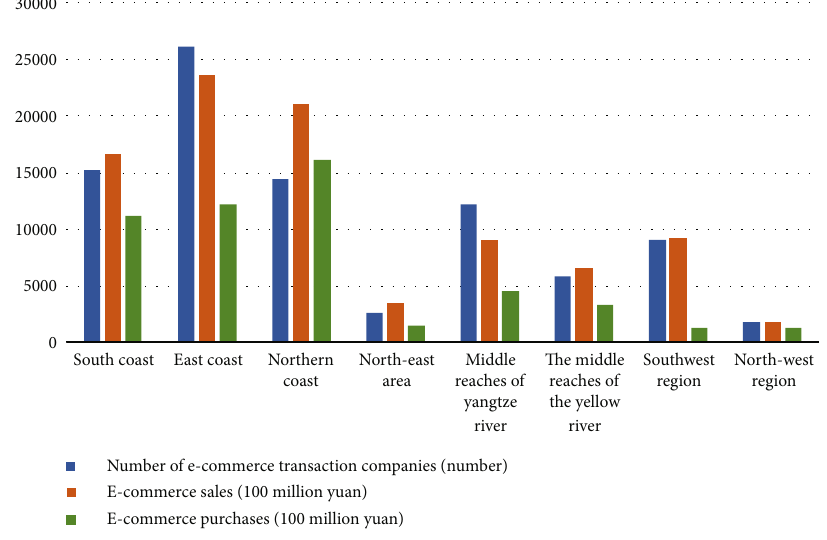
Figure 1: Regional e-commerce transactions.